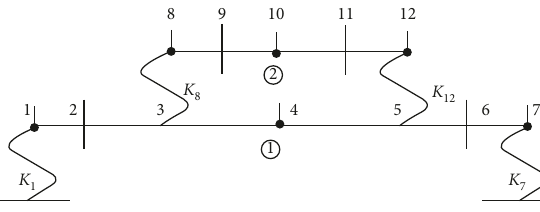
Figure 4: Computational model of a dual-rotor system.